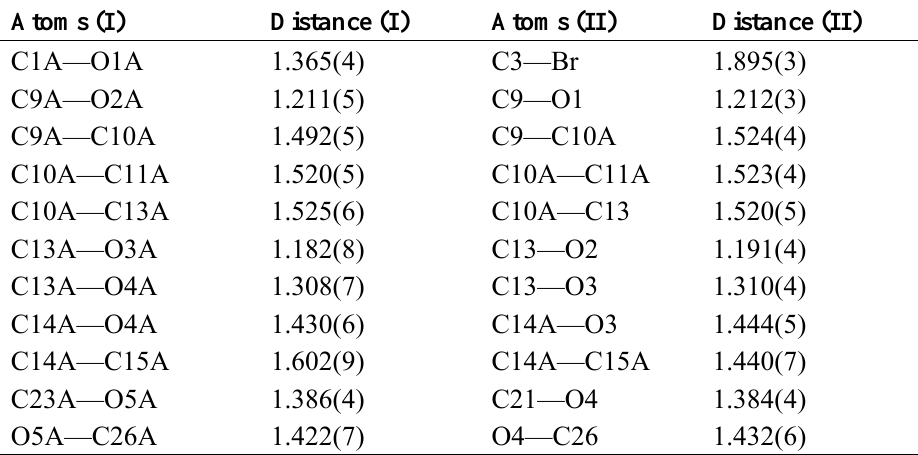
Table 2. Selected atom distances [Å] for ( I ) and ( II ) (disordered A atoms). Atoms (I) Distance (I) Atoms